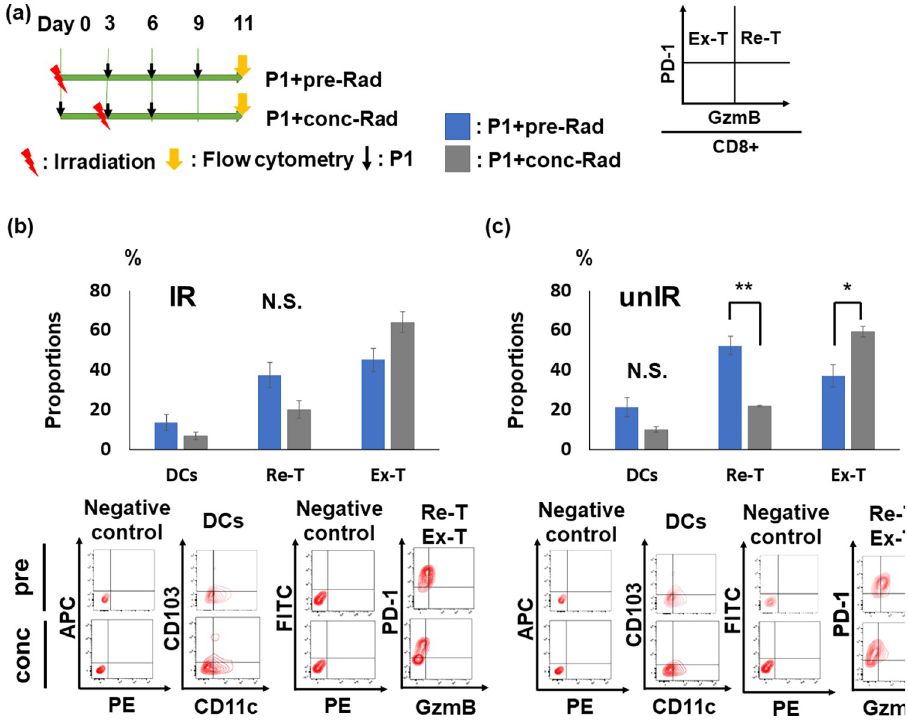
Fig 3. Comparison of the tumor immune microenvironment due to different sequences of radiation in P1 therapy. (a) A treatment scheme for P1+pre-Rad (n = 7) and P1+conc-Rad (n = 4) groups. (b and c) Proportions of activated DCs (DCs), reinvigorated T cells (Re-T), and exhausted T cells (Ex-T) in IR (b) and unIR tumors (c). Data are expressed as mean ± SEM. Representative contour plots are shown under corresponding graphs. � p < 0.05, �� p < 0.01. Abbreviations; P1: anti-PD-L1 antibody, IR: irradiated, unIR: unirradiated.